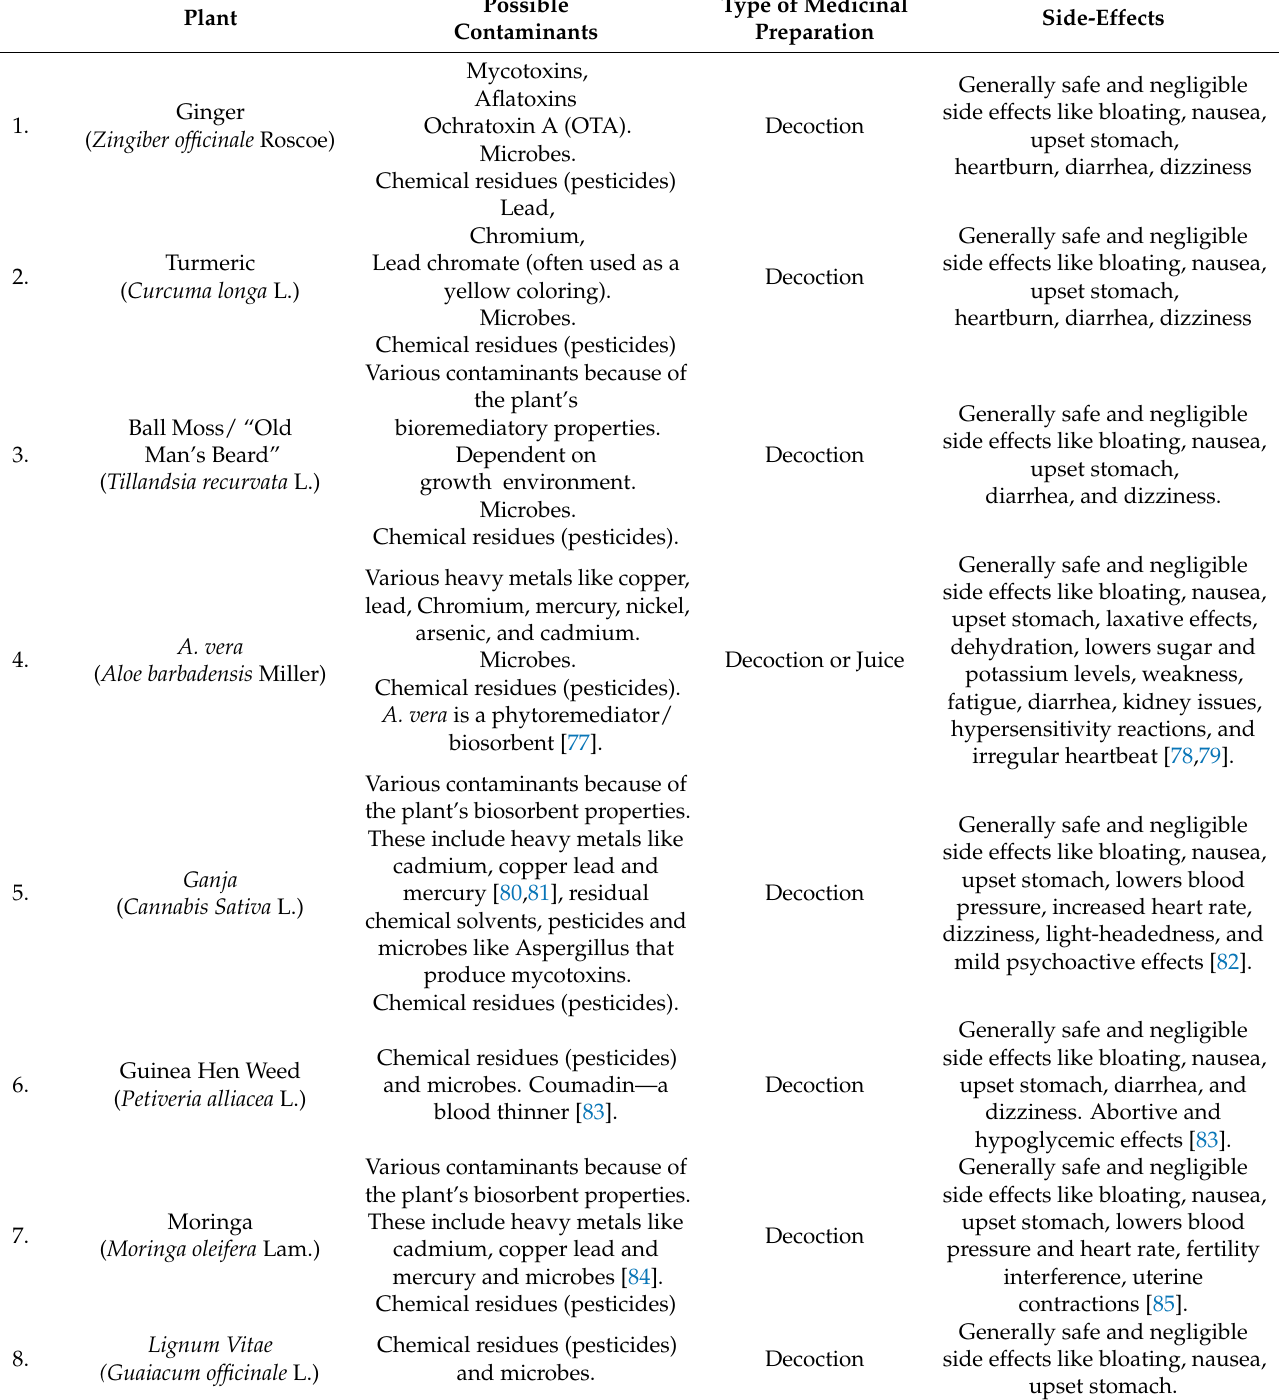
Table 3. Some toxic compounds and adverse side-effects associated with frequently used medicinal plants in